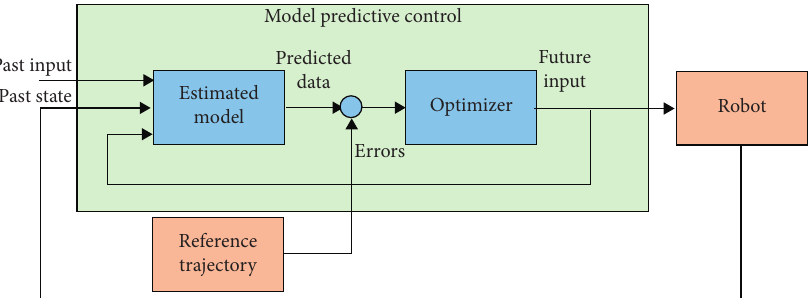
Figure 5: MPC controller internal rolling optimization process. The optimizer optimizes the current control input to obtain the optimal control input at the next